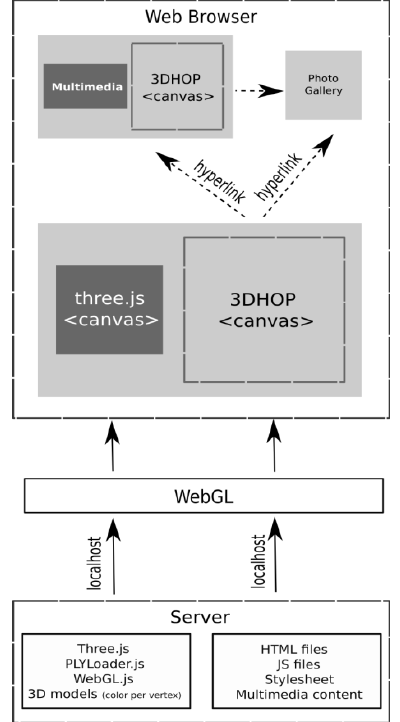
Figure 1. Overview of framework’s architecture and operation process